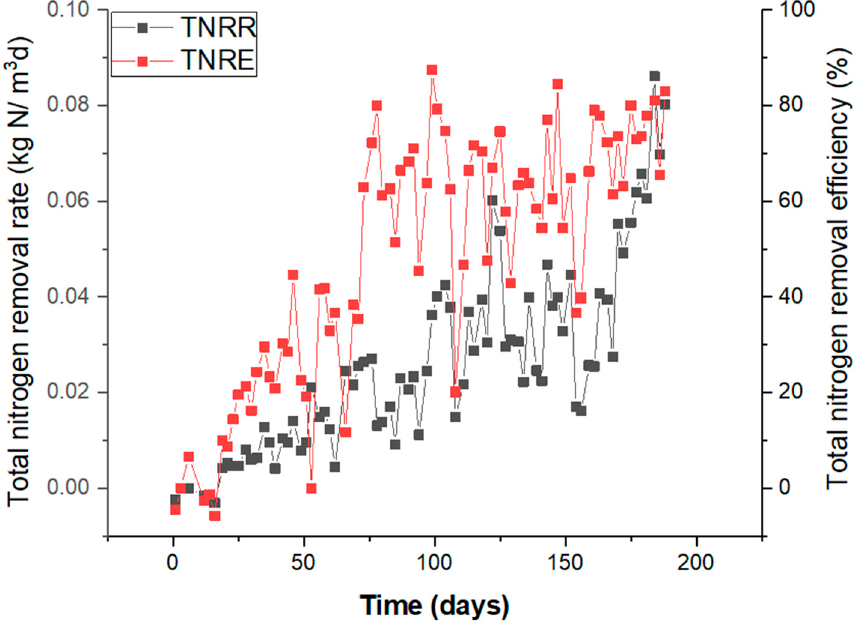
Figure 1. Overall performance of the reactor based on the TNRR and TNRE within 194 days of start-up.